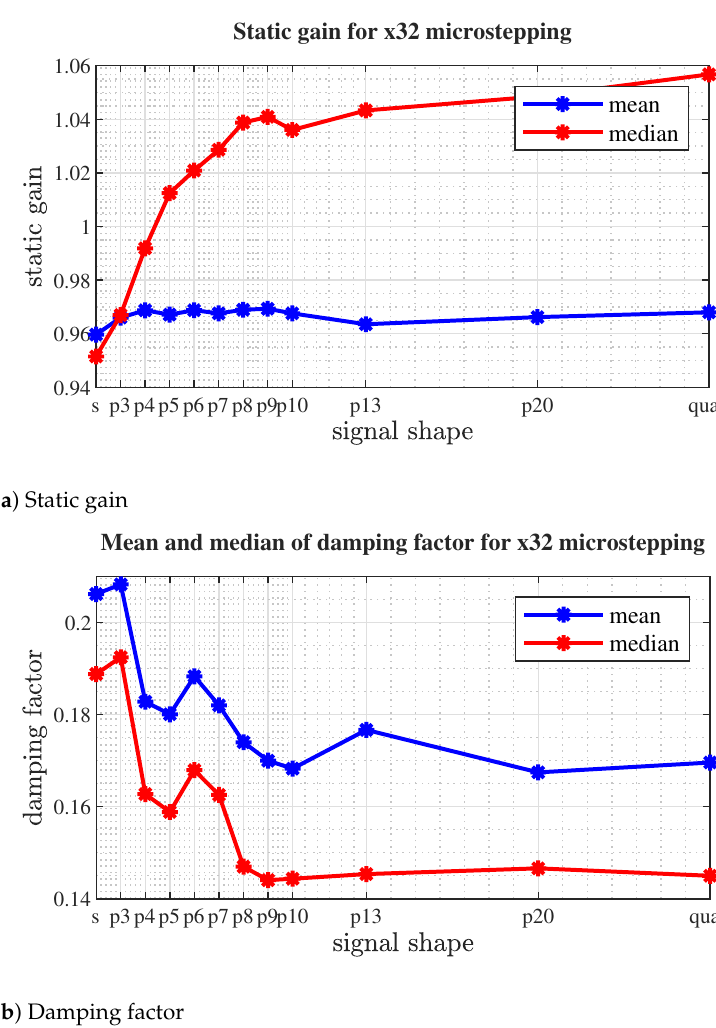
Figure 22. Medium and median values of estimated parameters for selected microsptepping signals at x32